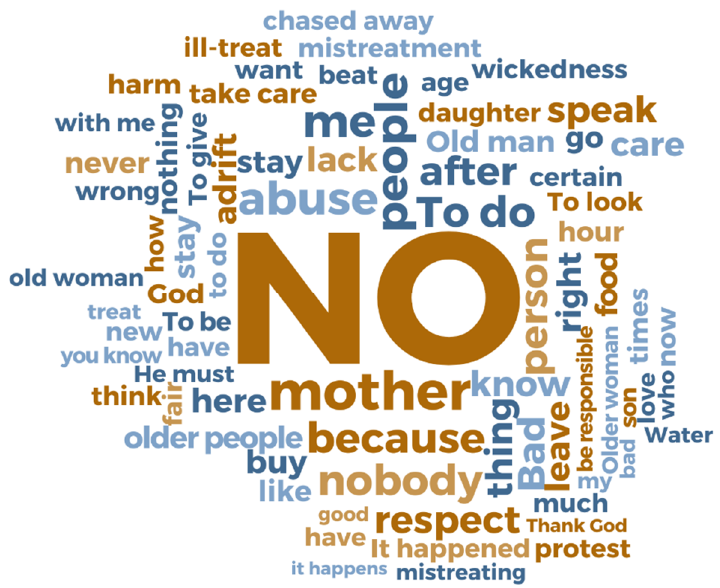
Figure 2. Word cloud—social representations of violence among Brazilian older people with func- tional